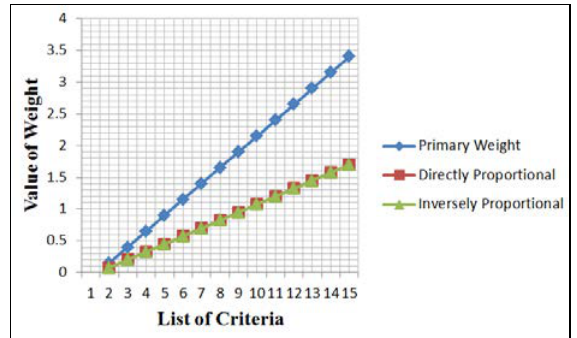
Figure 4. (Above) FIxed Distance Limits Vs Fixed Distance Conditions. (Below) The trend of graph of both directly and inversely is consistently increased From the Figure 4, this is a pure test of primary weight effects on the secondary weight. Due to the consistent distance limits and condition, both the secondary weight of directly and inversely react the same manner, which is consistently increase.